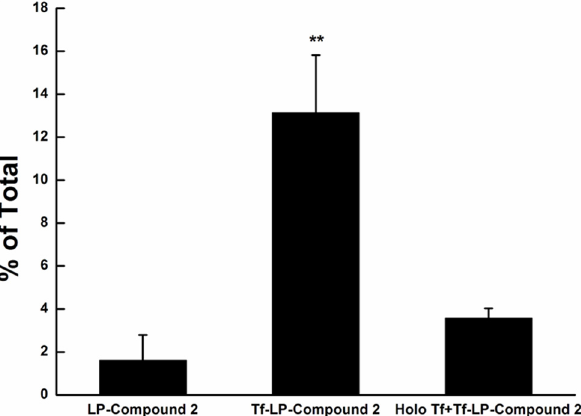
Fig 7. Cellular uptake of LP-Compound 2 and Tf-LP-Compound 2. Flow cytometry after incubation of LP-Compound 2, Tf-LP-Compound 2 and Tf-LP-Compound 2 with holo Tf. Data represent the mean ± standard deviation (n = 3)( ** p < 0.01 vs LP-Compound